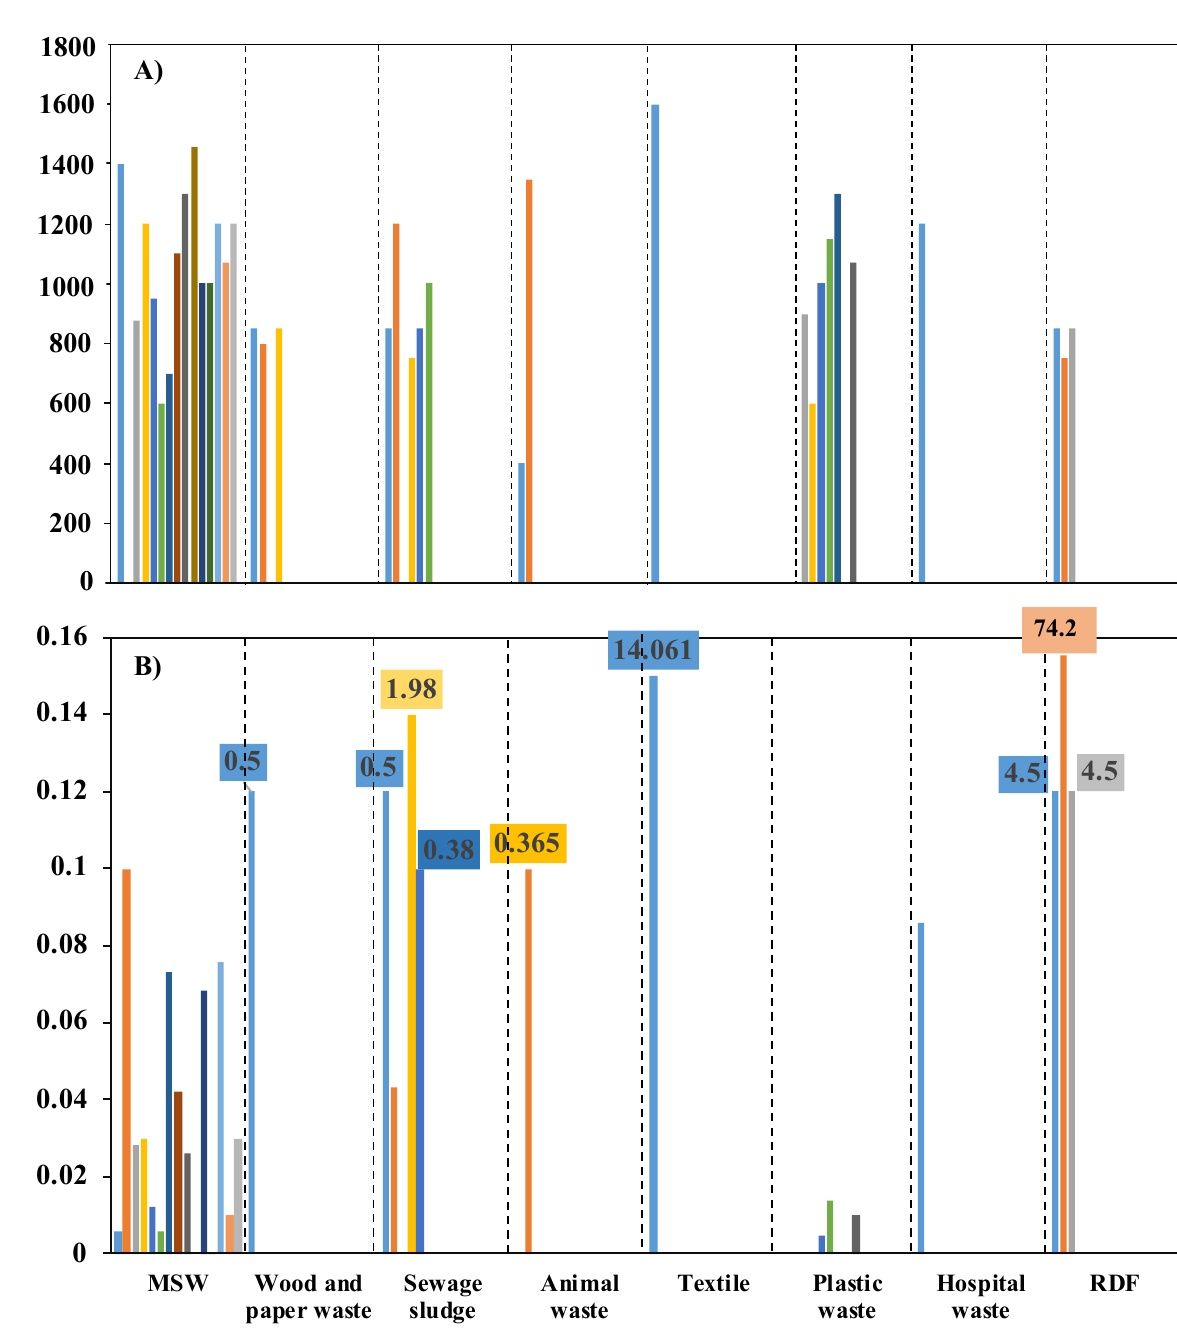
Figure 2. The bar chart on the top shows the temperature at which the dioxin was measured ( A ). The bar chart at the bottom shows the dioxin concentration based on the feedstock used in the literature ( B ). There is one cluster of bars for each substrate. Each one of these clusters has a few thin bars right next to each other, meaning that every measurement reported has its own bar, even the ones that measured zero dioxin or below the detection limit (empty space between bars). Since the measured concentration of PCDD/Fs reported for different substrates varies a lot, the Y axis has to be broken more than once. To make it easier for readers, the real values of measured PCDD/Fs were added on top of some of the bars for which a higher amount of PCDD/Fs has been reported. The dashed black lines are for ease of reading and separating the substrates from each other.